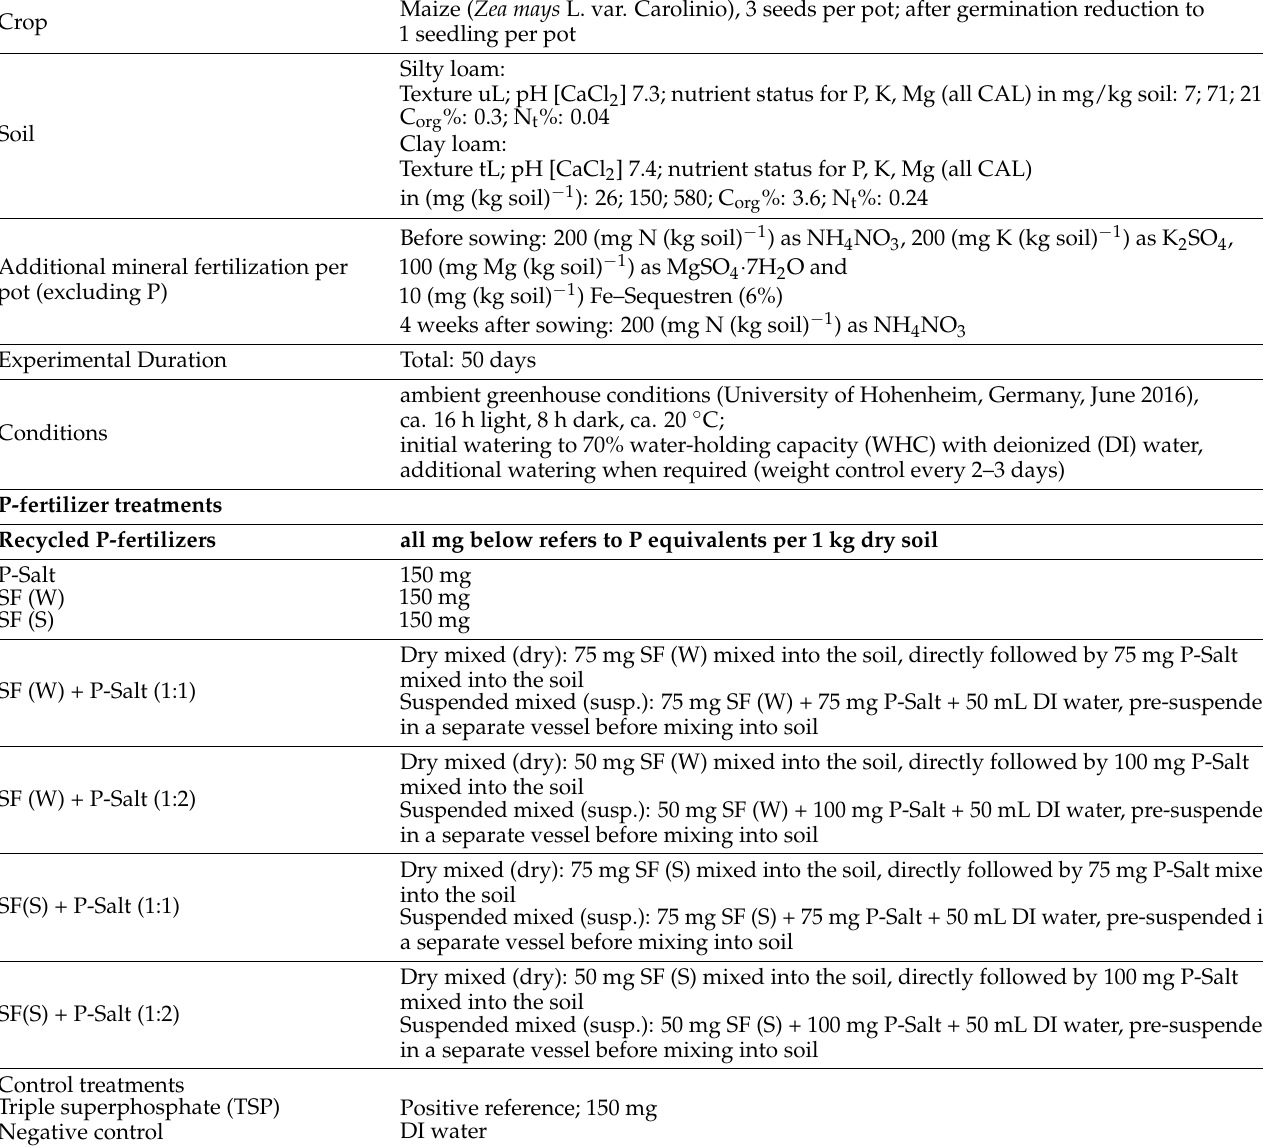
Table 2. Experimental setup of the greenhouse pot